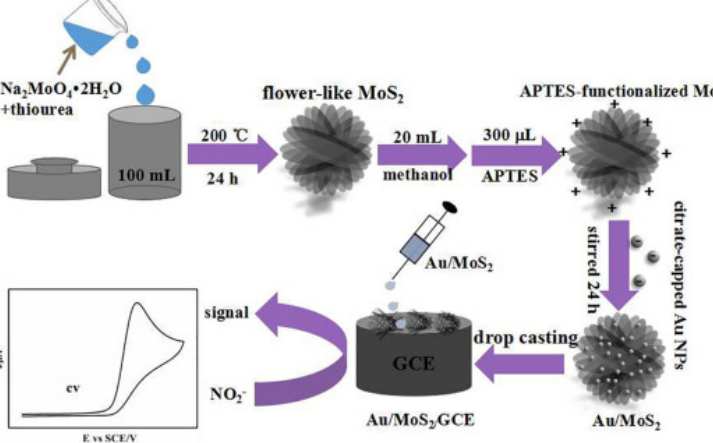
Figure 9. Synthesis of gold nanoparticles-MoS 2 nanocomposite and gold nanoparticles-MoS 2 -GC electrode explained by the schematic. Reprinted with permission from Ref.